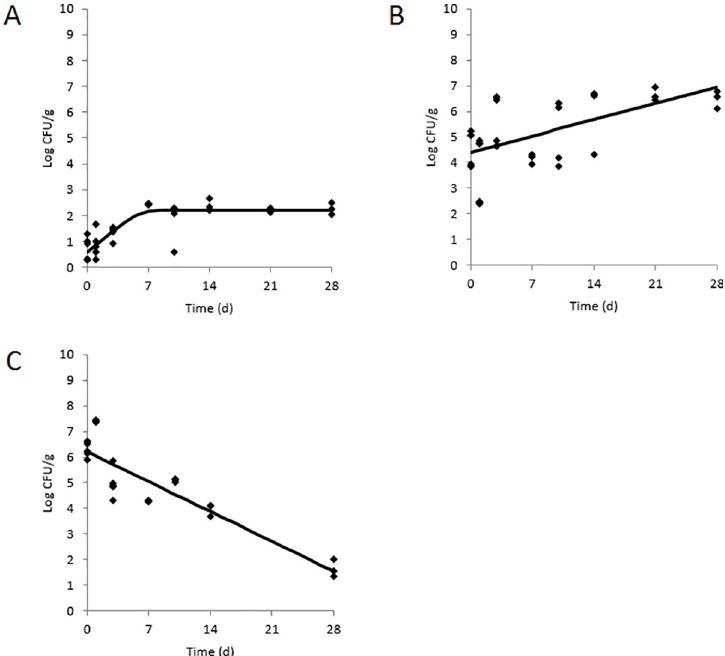
Fig 3. Survival of L . monocytogenes in hummus prepared with A) contaminated tahini or B) contaminated mashed chickpeas, and in C) guacamole prepared with contaminated mashed avocado during 28 d storage at 10˚C. Observed data (black circles) with standard deviations (n = 9) and predicted growth models (solid black lines) are shown.